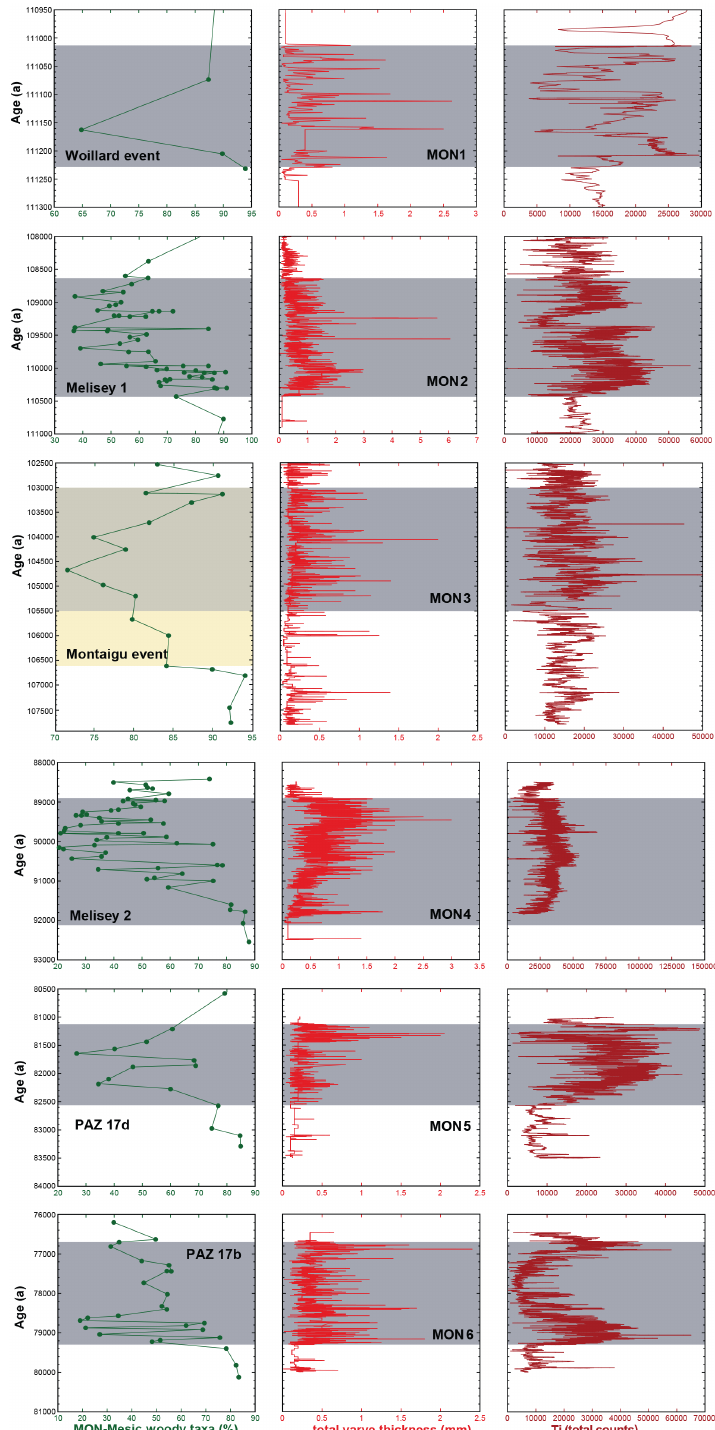
Figure 6. MON-Mesic woody taxa, total varve thickness and Ti-counts zoomed in on the Mediterranean stadials MON 1 to MON 6. Reso- lution of the pollen samples is shown as green points on the mesic woody